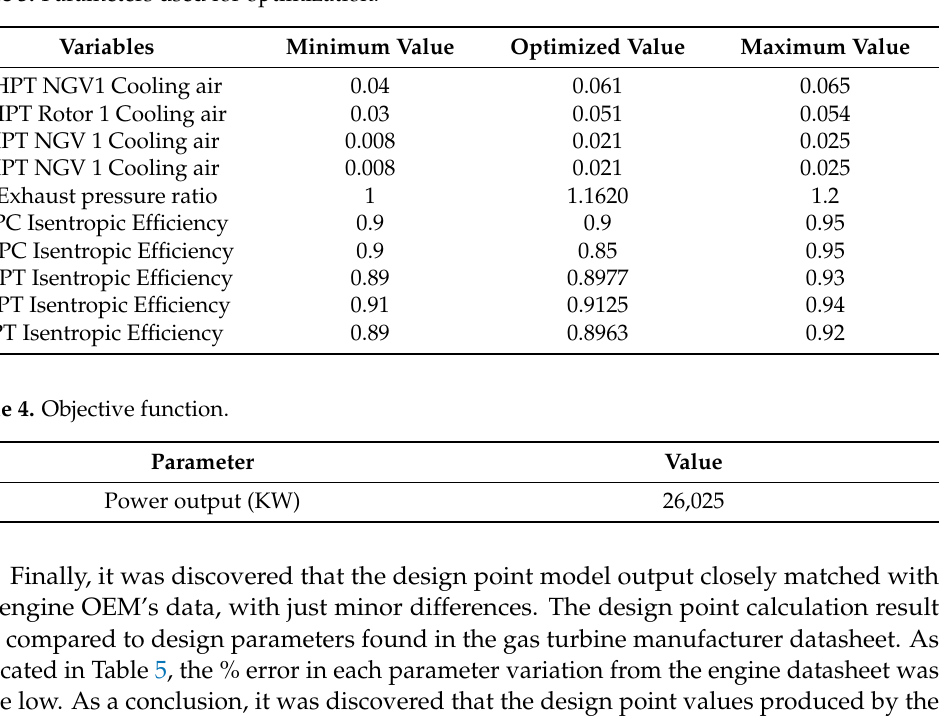
Table 3. Parameters used for optimization.